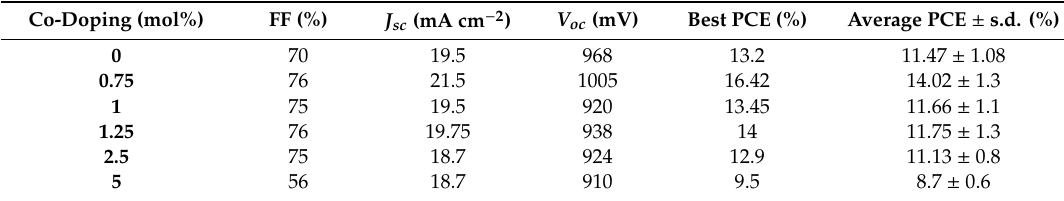
Table 2. Photovoltaic performance by J / V measurements with reverse scan under standard illumination (100 mW cm −2 ) for champion devices and averaged.